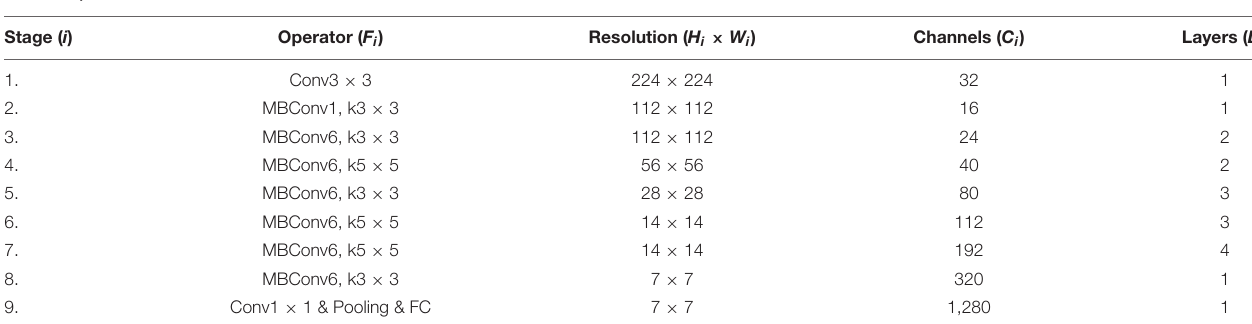
TABLE 3 | Parameters of the EfficientnetB0